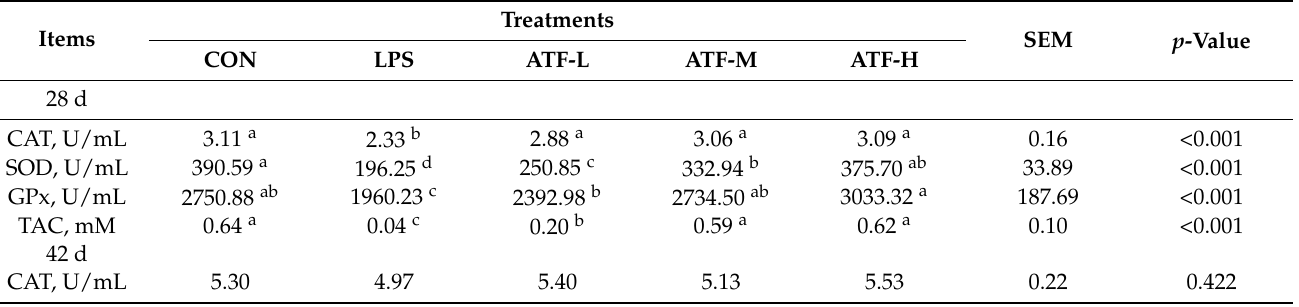
Table 5. Effect of ATF on serum antioxidant indexes in broilers challenged with